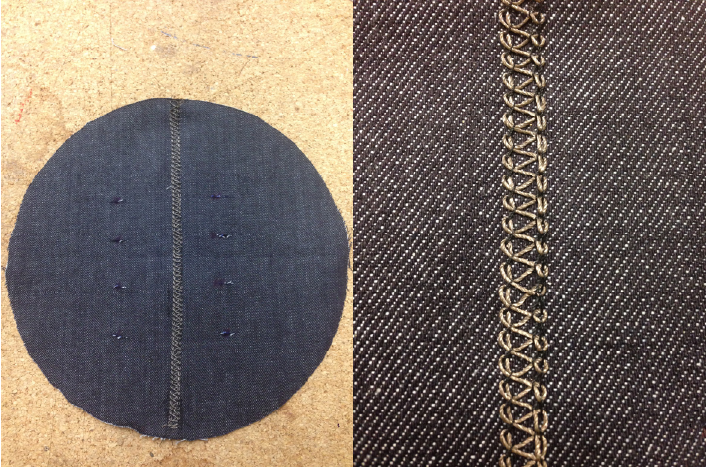
Figure 2. Denim sample ( left ) with a zoom of the stitched sensor ( right ).